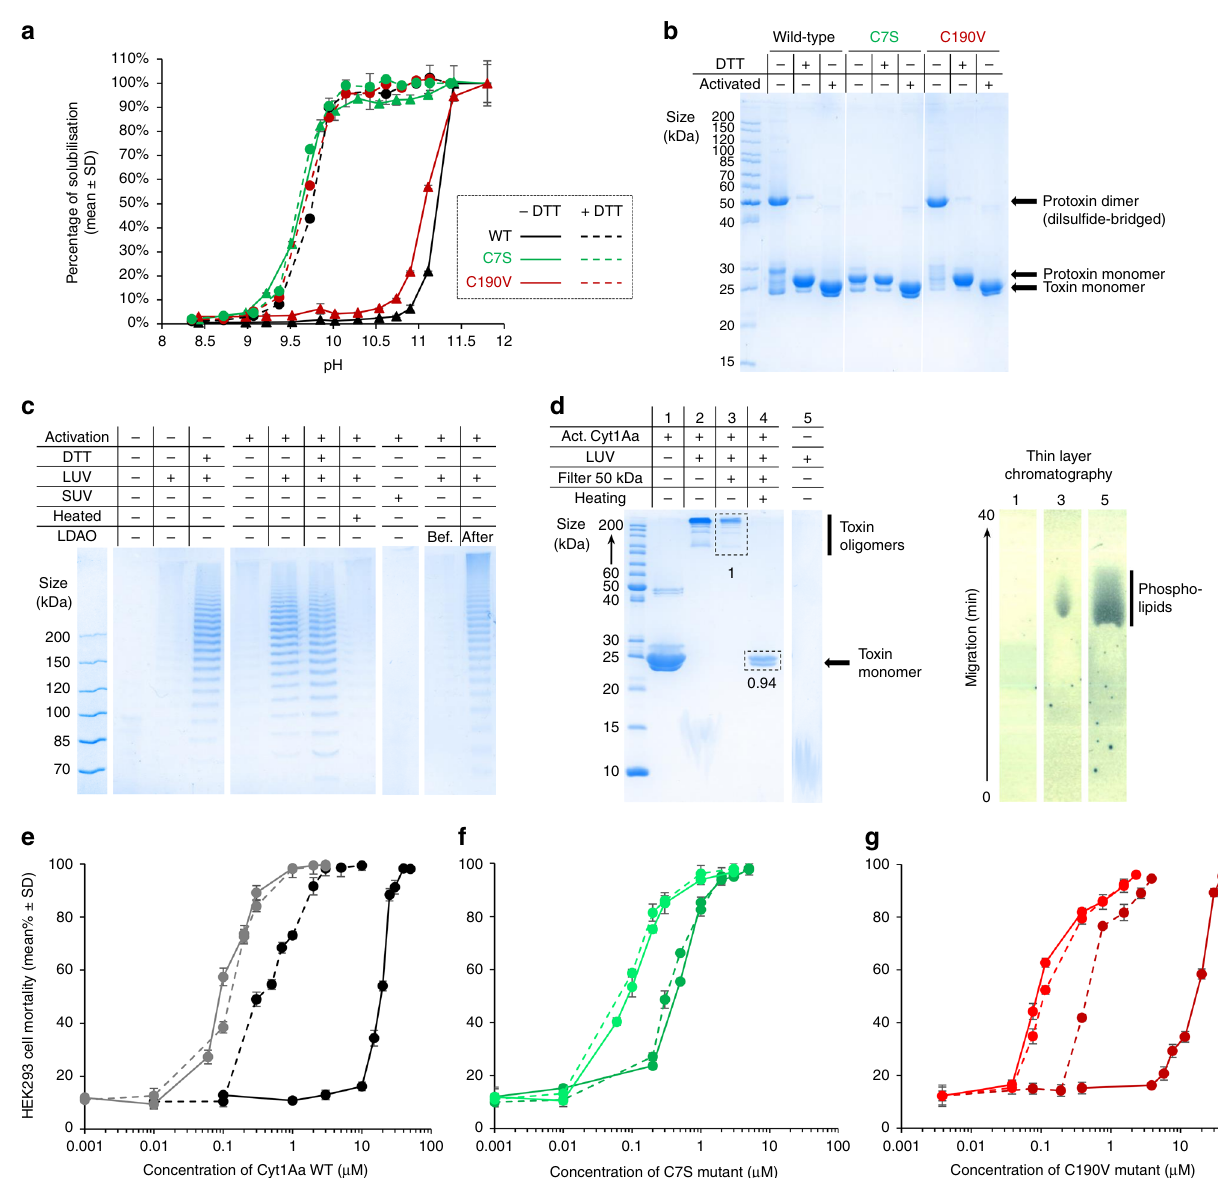
Fig. 4 The disul fi de bridge levels the pH sensitivity of crystals and abrogates toxicity. a pH-dependent crystal dissolution. b Electrophoresis on a 12% SDS-PAGE gel supports that the wild-type (WT) dimer released upon dissolution of crystals in absence of DTT is disul fi de-bridged at position C7. c Both the protoxin and toxin monomers can form membrane-bound oligomers (MBO) in presence of 100 nm radius liposomes, as revealed by a ladder-like pro fi le on 6% SDS-PAGE gels. The disul fi de-bridged dimer is unable to form MBO. d MBO are complexes of non-covalently bound Cyt1Aa monomers (as revealed by 15% SDS-PAGE of heated MBO) with phospholipids (as indicated by TLC). e – g Cytotoxicity of WT ( e black), C7S ( f green) and C190V ( g red) Cyt1Aa was assayed against HEK293 cells in the three forms that may coexist upon dissolution of WT crystals, i.e. the disul fi de-bridged protoxin dimer (solid dark lines; dissolution at pH 11.8 without DTT), the protoxin monomer (dashed dark lines; dissolution at pH 11.8 with DTT), and the activated toxin monomer in absence (solid light line) or presence (dashed light lines) of DTT. The WT activated toxin monomer is 4 and 200 times more active than the monomeric protoxin and the disul fi de-bridged dimer, respectively. Error bars = SD. Source data are provided as a Source Data fi (Fig. 4c), demonstrating a requirement for a fully formed and Supplementary Fig. 9). Thus the disul fi de bridge, but not the membrane with a minimal radius of curvature. MBO persist N-terminal propeptide, can abrogate MBO formation. Thin layer after solubilization of their supporting liposomes and, despite an chromatography (TLC) nonetheless indicates that the N-terminal apparent spacing of bands by 11 – 17 kDa in SDS-PAGE gels propeptide masks half of the lipid binding interface in the (Supplementary Fig. 10), dissociate into full-size monomers upon oligomers, with protoxin and toxin MBO respectively featuring heating to 95 °C (Fig. 4d and Supplementary Fig. 6). This ~11.1 ± 2.6 ( N = 4) and ~22.1 ± 6.9 ( N = 4) phospholipids per observation shows not only that MBO formation entails drastic Cyt1Aa monomer (Fig. 4d), consistent with previous estimations conformational changes after which Cyt1Aa may not solubilize as based on liposome disruption assays 23 . MBOs do not form upon contact of toxins with lipids solubilized in detergent micelles or a monomer unless heated, but also that there is no further bilayered in two-times smaller liposomes (~50 nm radius; SUVs) proteolytic cleavage occurring post-insertion into membrane nor